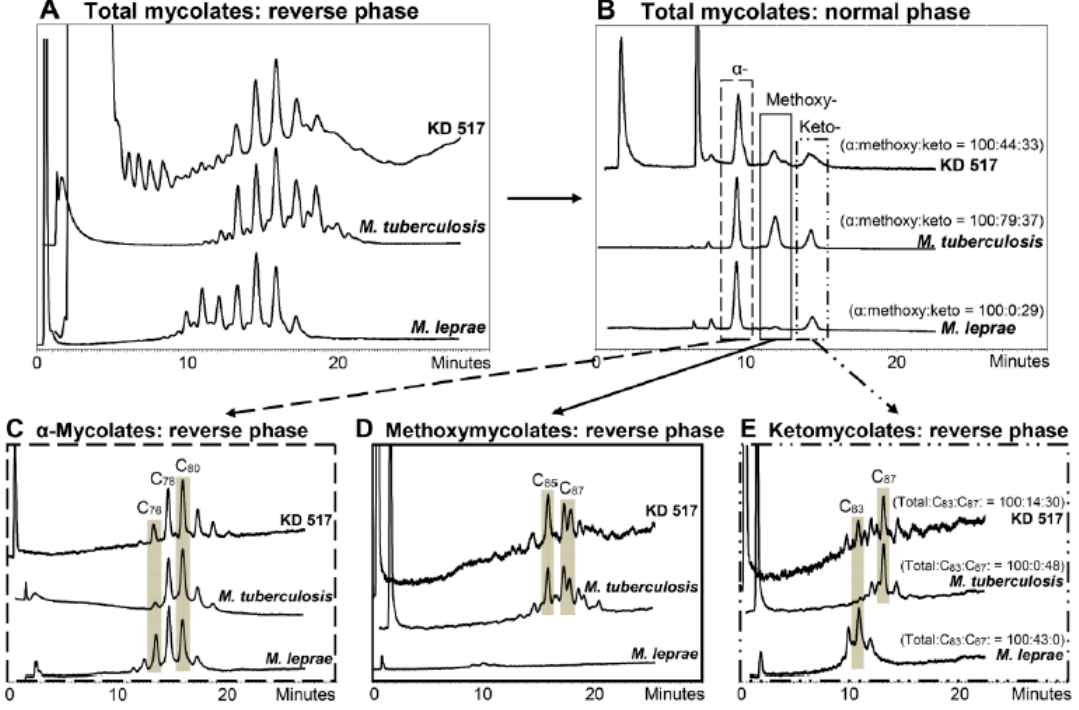
Figure 8. Mycolic acid profiles from Kiskundorozsma, Hungary, KD 517 [13]. ( A ) Total Figure 8 . Mycolic acid profiles from Kiskundorozsma, Hungary, KD 517 [13]. A . Total mycolates, reverse phase HPLC. B . Collected total mycolates (MAs), normal phase; the normalized ratios of the